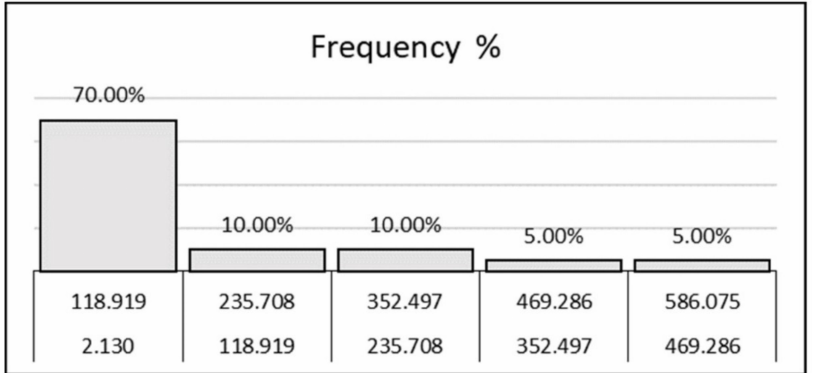
Figure 3. Worldwide positioning ranking. Note: five (5) groups are formed, and the frequency is shown in the figure.